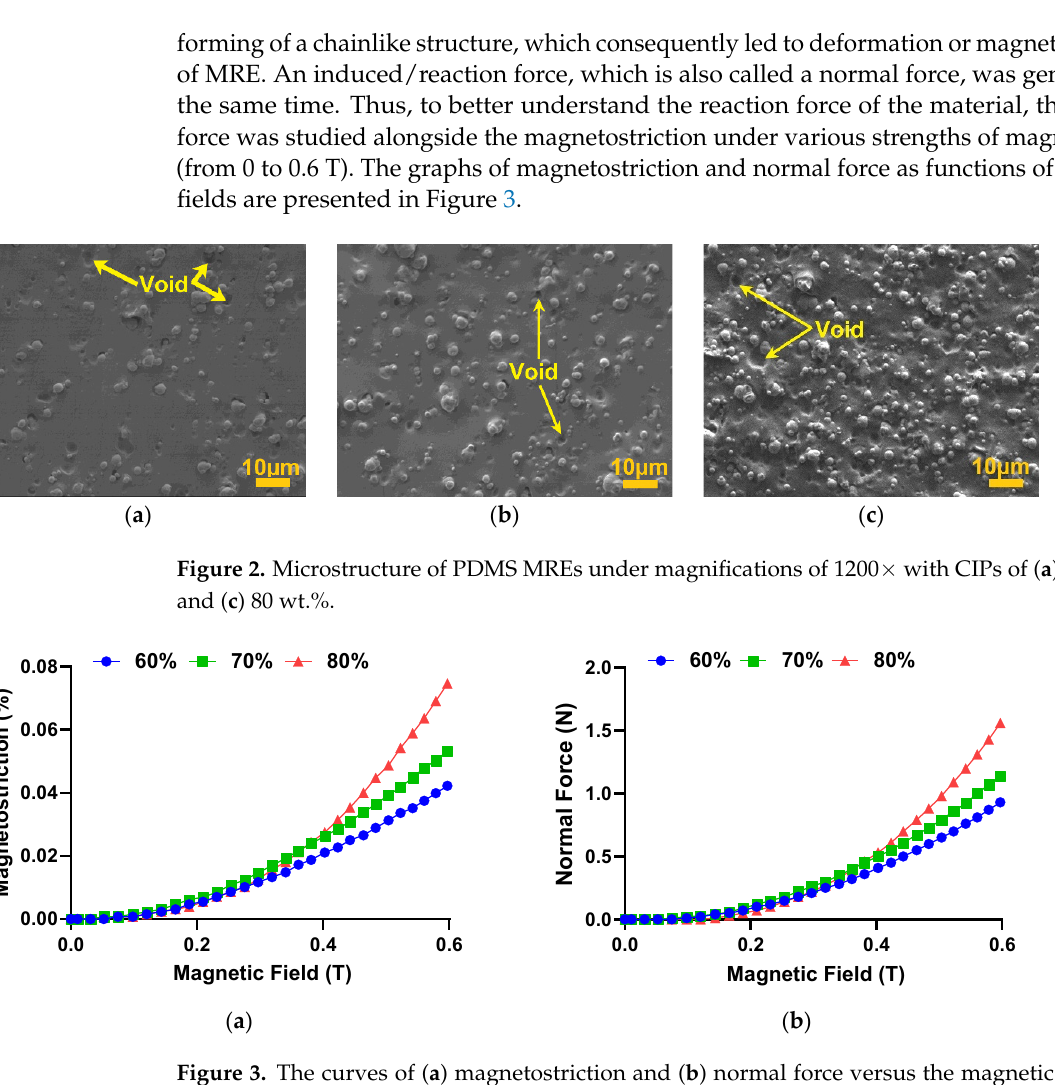
Figure 3. The curves of ( a ) magnetostriction and ( b ) normal force versus the magnetic field with various concentrations of CIPs.